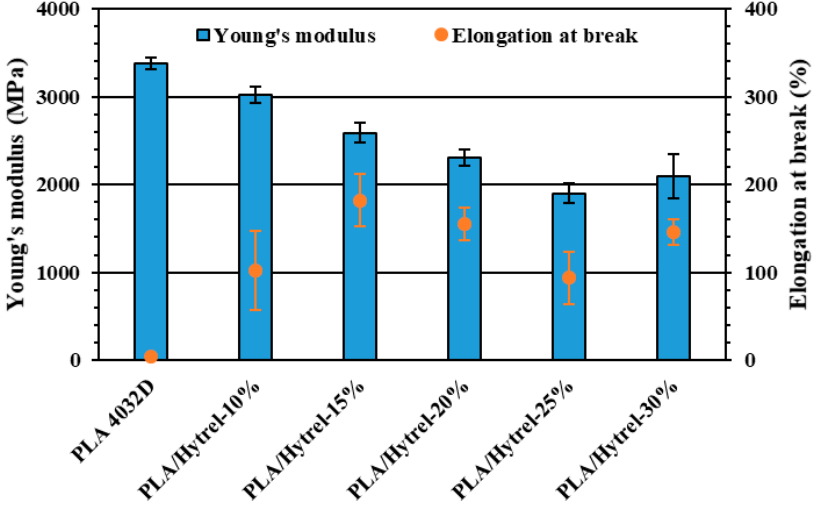
Figure 6. Young’s modulus and elongation at break of neat PLA and compounded PLA with different Hytrel contents (10%, 15%, 20%, 25%, and 30%).